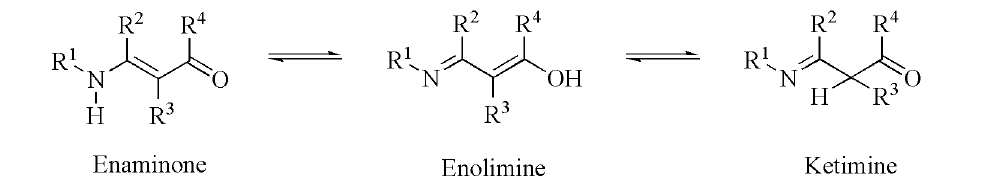
Figure 1. Enaminones and their tautomers.